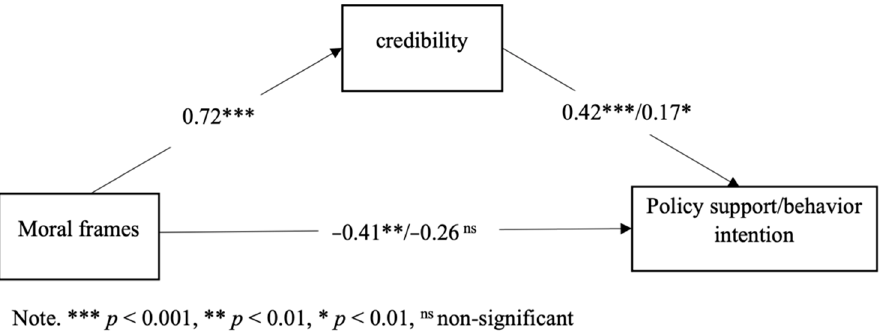
Figure 2 . Mediation only model with standardized coefficients in the pilot study. Figure 2. Mediation only model with standardized coefficients in the pilot